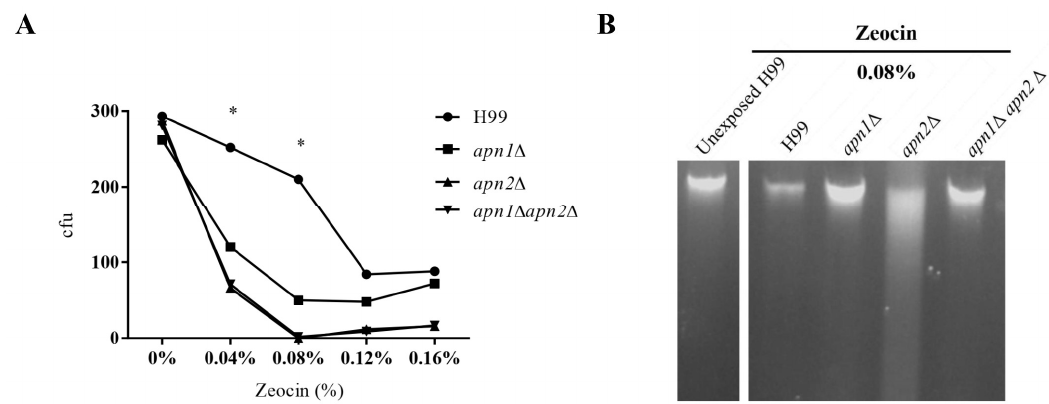
Figure 4. The ablation of the predicted Apn1 and Apn2 proteins sensitized C. neoformans yeasts to the exposure to Zeocin. ( A ) Cell viability of the WT and mutant strains after incubation with different concentrations of Zeocin. Yeasts from WT and mutant strains were cultured in liquid YPD containing 0.04%, 0.08%, 0.12% or 0.16% Zeocin for 1 h, at 30 °C, 150 rpm. Cells were then PBS-washed and plated on YPD agar for CFU counting. Percent of viable cells was calculated from the CFU counting. Data are presented as mean of three replicates. Statistical test: One-way ANOVA with Dunnett’s post-test, * p < 0.05. ( B ) Electrophoretic analysis in 1% agarose gel stained with 0.5 µg/mL EtBr of C . neoformans strains DNA after exposure to 0.08% Zeocin for 1 h. Unexposed mutant and H99 strains presented DNA with no fragmentation. Genomic DNA from the unexposed H99 strain was used as control. The result is representative of three independent experiments.